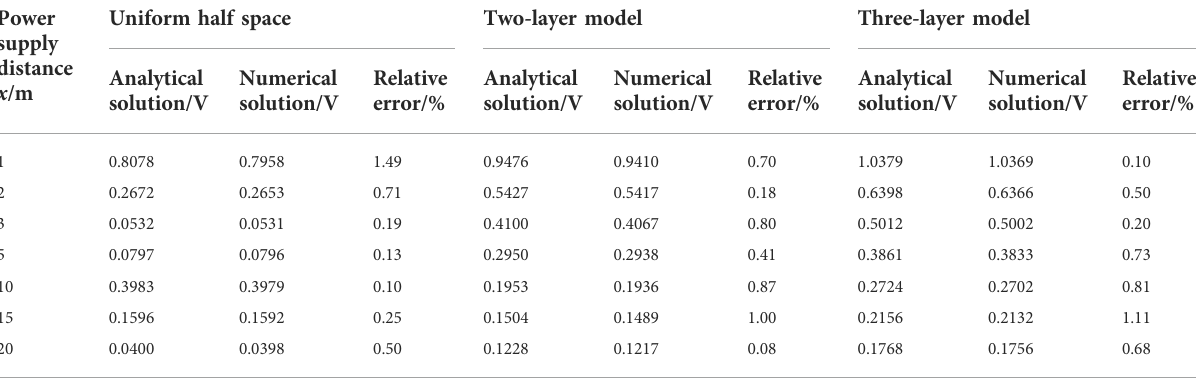
TABLE 2 Data showing a comparison of the analytical and numerical solutions for the two-dimensional geoelectric cross-section potential of the point source survey. Power supply